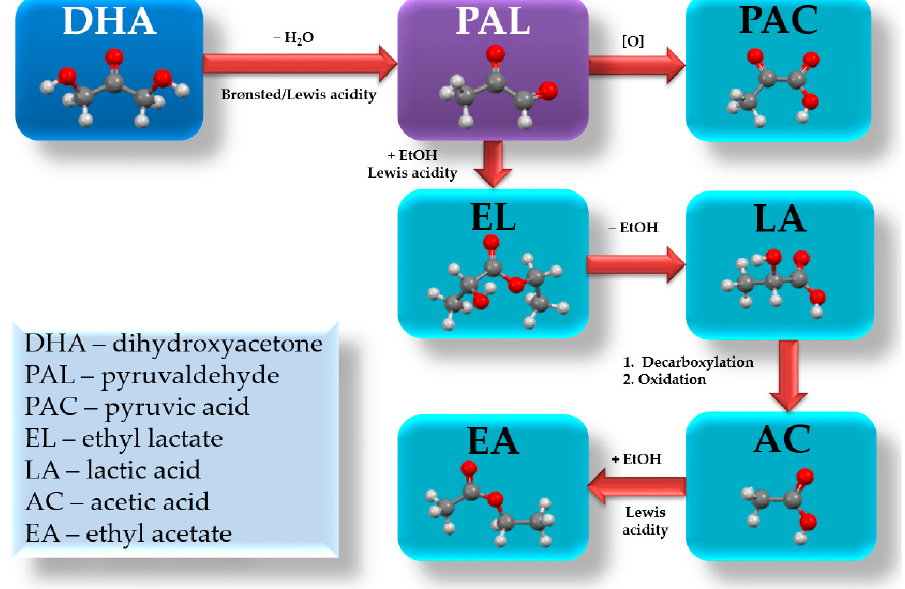
Figure 10. Scheme of the reaction pathways of DHA observed experimentally.